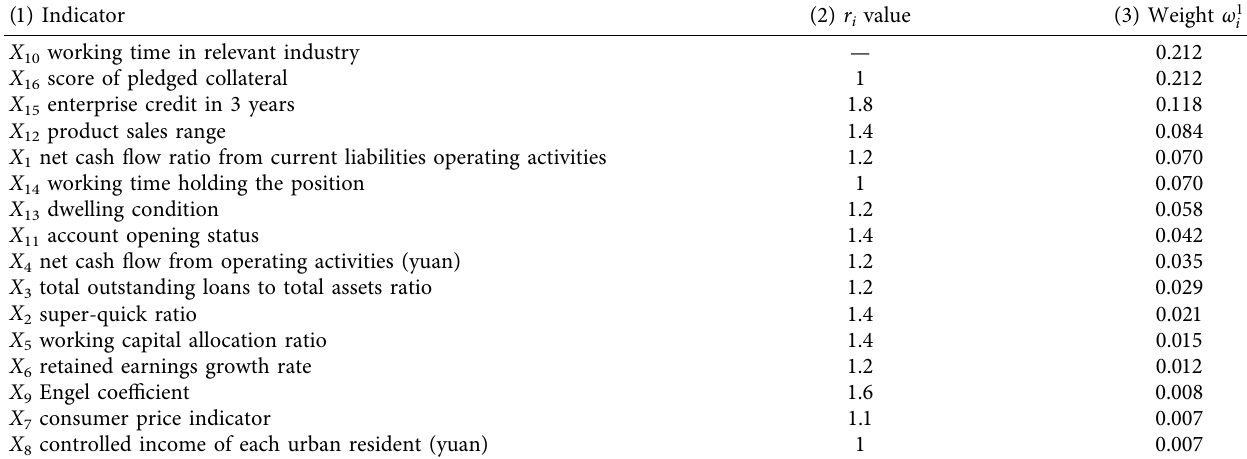
Table 6: Weights based on the G1 method.